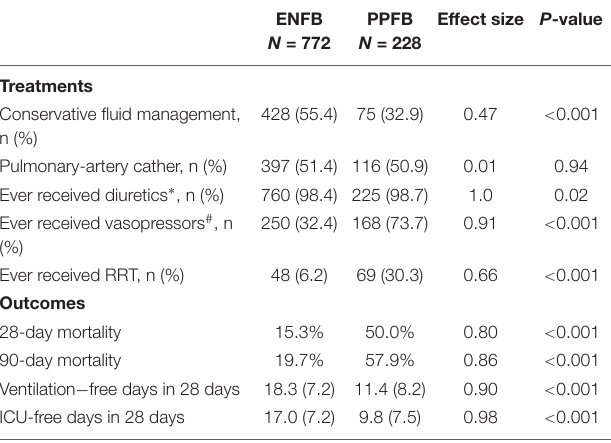
TABLE 2 | Treatments and outcomes between two